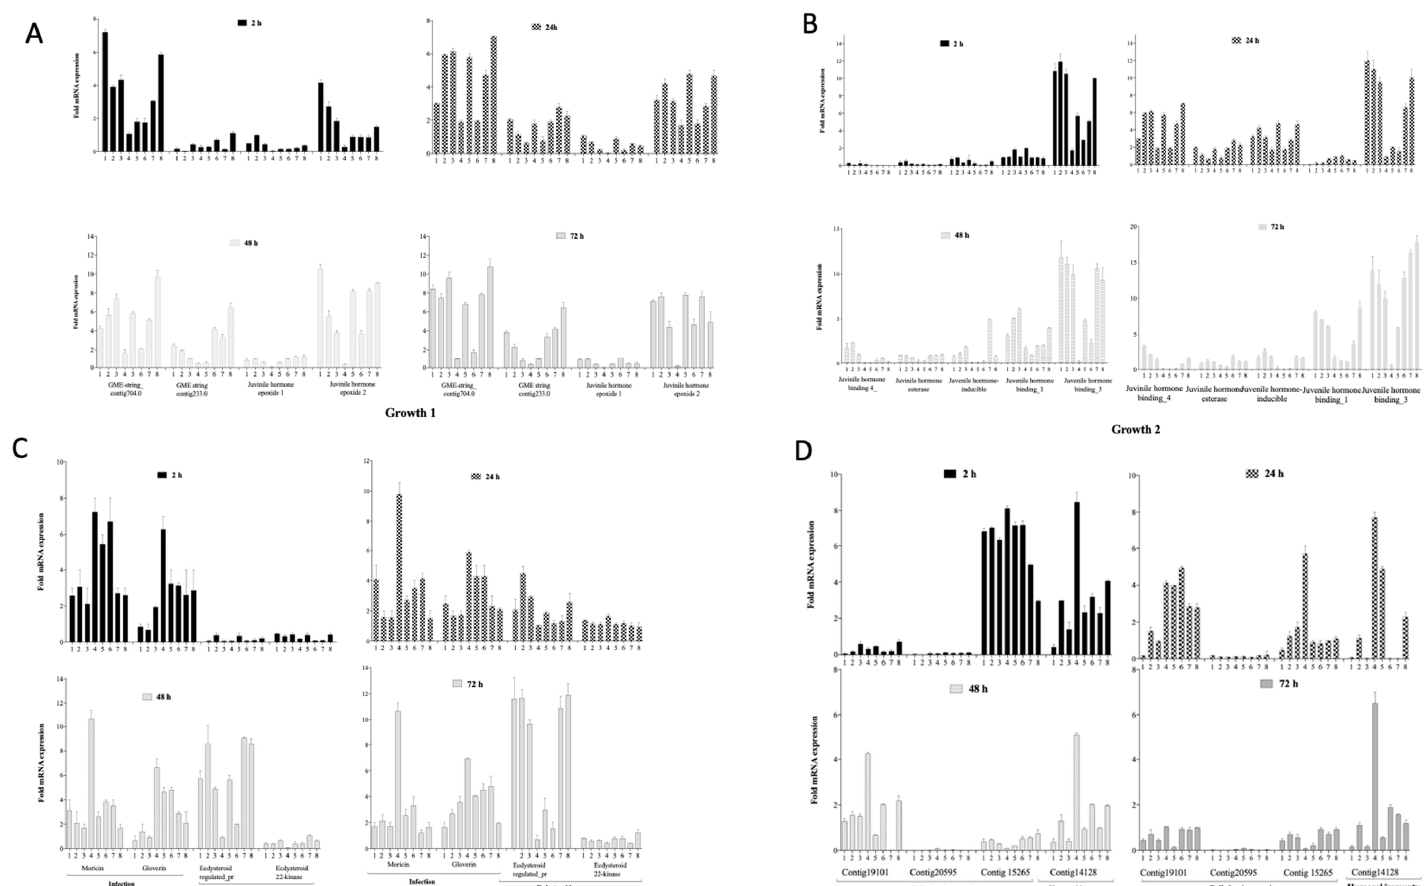
Figure 3. Expression of 17 G. mellonella growth markers during C. di ffi cile colonisation and phage therapy regimens. The relative expression levels of ( A , B ) 9 growth, ( C ) infection and reproduction and ( D ) cellular and humoral genes were examined during C. di ffi cile colonisation in G. mellonella larvae and when undergoing di ff erent phage therapy regimens. G. mellonella larvae were either untreated (1), treated with empty needles (2), 10 µ L of either BHI (3), or 10 5 CFU / mL of CD105LC2 bacterial culture (4). The larvae were also treated with a co-infection of the phages (10 6 PFU / mL) and bacteria (5), remedially (6) or prophylactically (7), and compared to a group of larvae treated with just the phage cocktail (8). Experiments were repeated three times. Values were normalised using the housekeeping gene 18S rRNA and analysed using GraphPad Prism